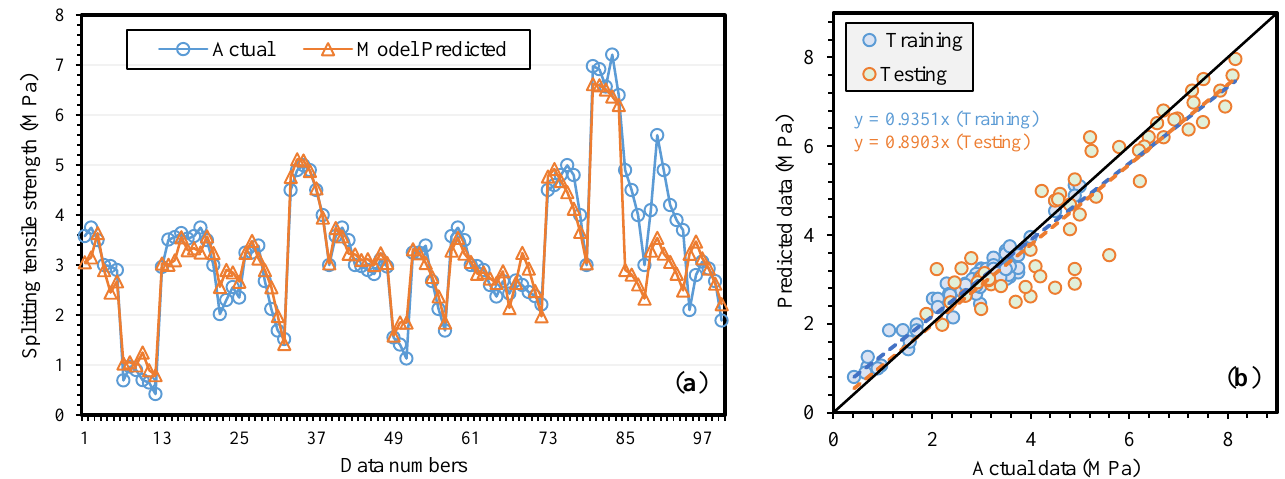
Figure 4. Comparison of actual and model predicted splitting tensile strength ( a ) variation in data ( b ) scattered plot.